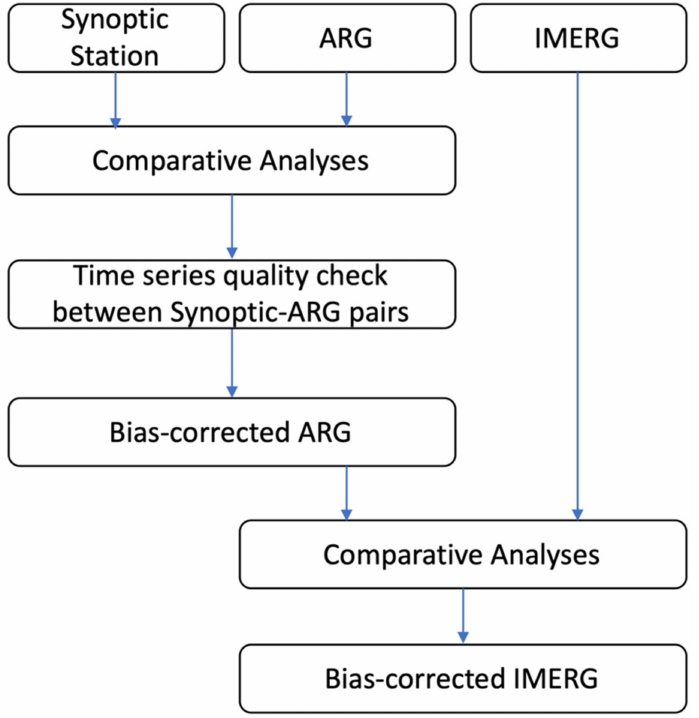
Figure 2. Process flow of comparative analyses performed using synoptic stations, ARGs, and IMERG